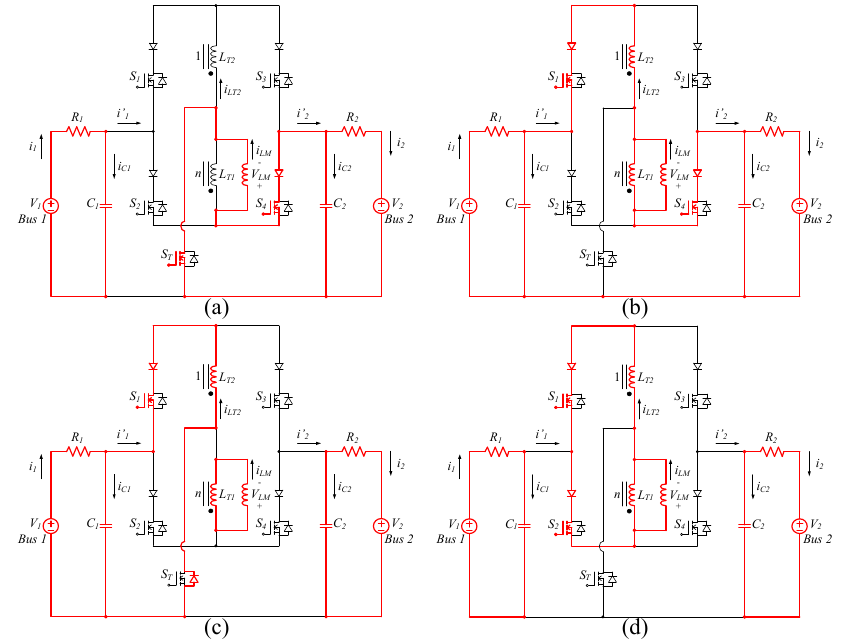
Figure 3. Current paths (in red) for the operating states of the reverse mode. ( a ) State S 4 T ; ( b ) State S 14 ; ( c ) State S 1 T ; ( d ) State S 12 .